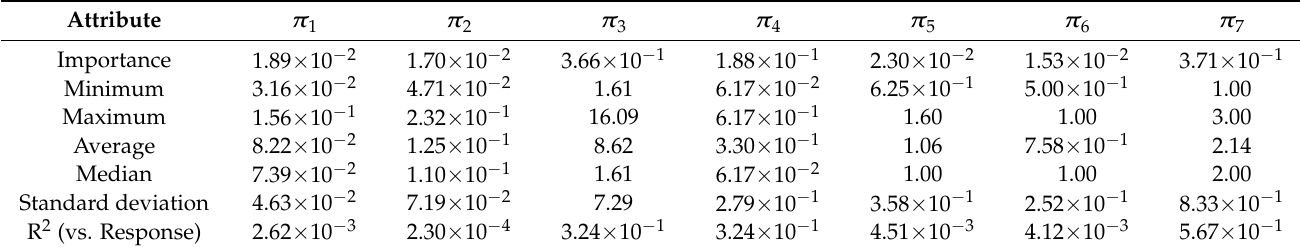
Table 8. The statistics of the input variables to develop the new correlation with regards to the response variable ( RF ).